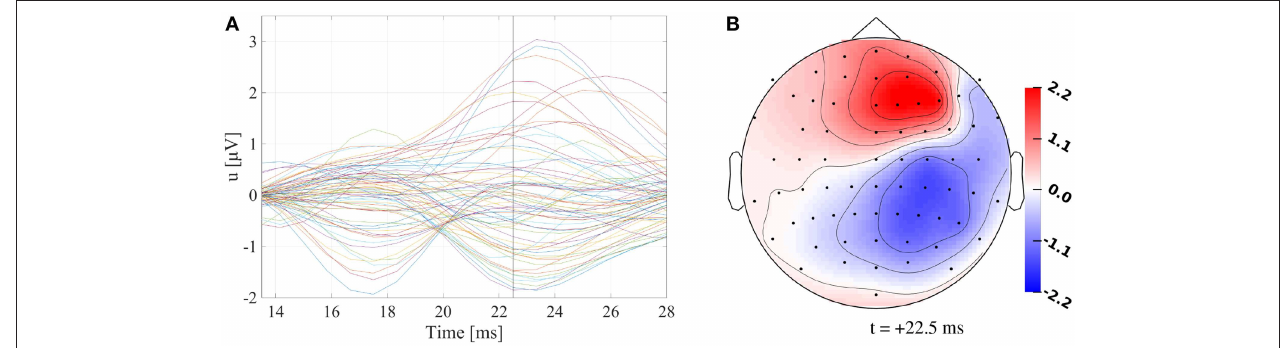
FIGURE 1 | (A) Butterfly plot of preprocessed SEP data. Vertical black line marks + 22.5 ms. (B) Topography plot of preprocessed SEP data at + 22.5 ms. Values are indicated in µ V.